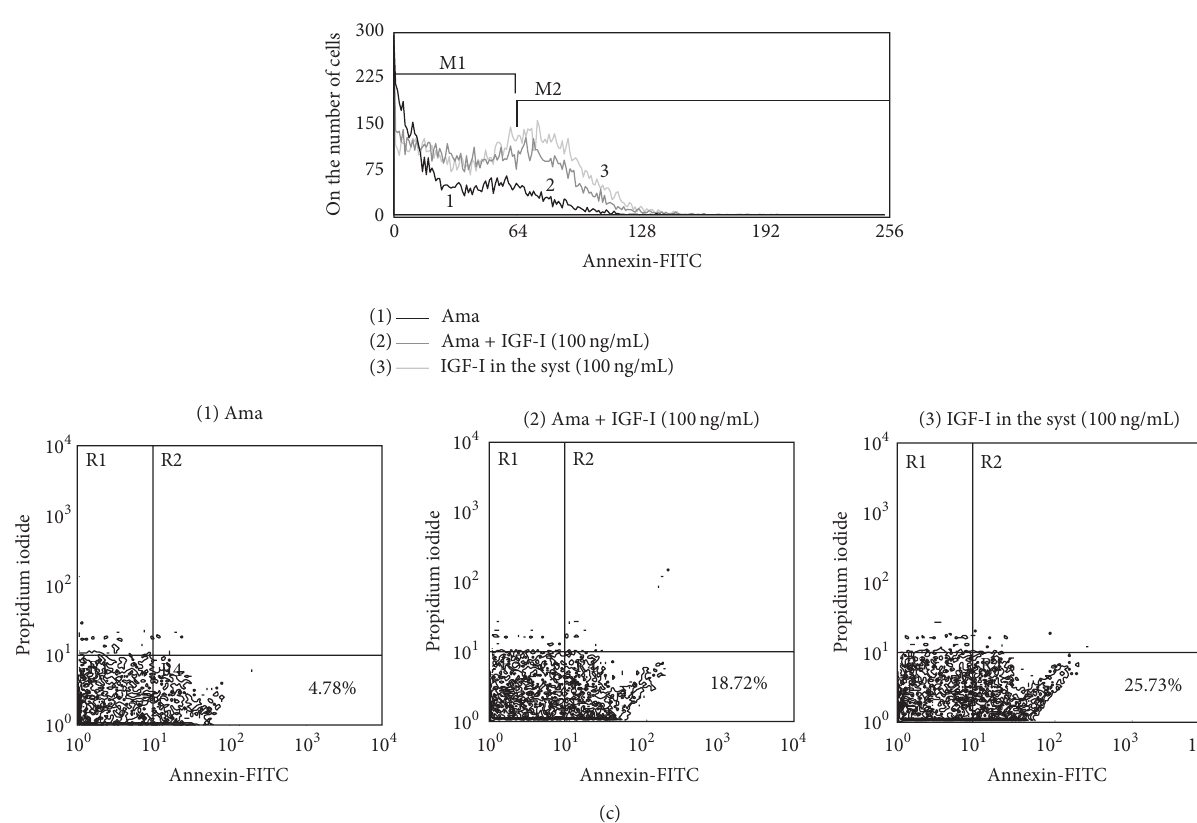
Figure 3: Effect of IGF-I on Annexin V binding to L. (L.) amazonensis after IGF-I stimulation. Annexin V-FITC binding to parasites by flow cytometry. (a) Controls. (1) Negative control-amastigotes without Annexin V-FITC label; only with propidium iodide (PI) stain; (2) Unstimulated amastigotes. (3) Positive control-amastigotes after 8mM H 2 O 2 stimulation. (b) IGF-I (50 ng/mL) stimulation and (c) IGF-I (100ng/mL) stimulation. (1) Unstimulated amastigotes. (2) Amastigotes prestimulated for 5 min and maintained in culture without IGF-I for 24 h. (3) Amastigotes maintained in culture (syst) with IGF-I for 24 h. The results are representative of 3 independent experiments. Data were collected in a BD FACScalibur and analyzed by CellQuest Pro (BD Biosciences). A total of 10,000 events were harvested from each sample.